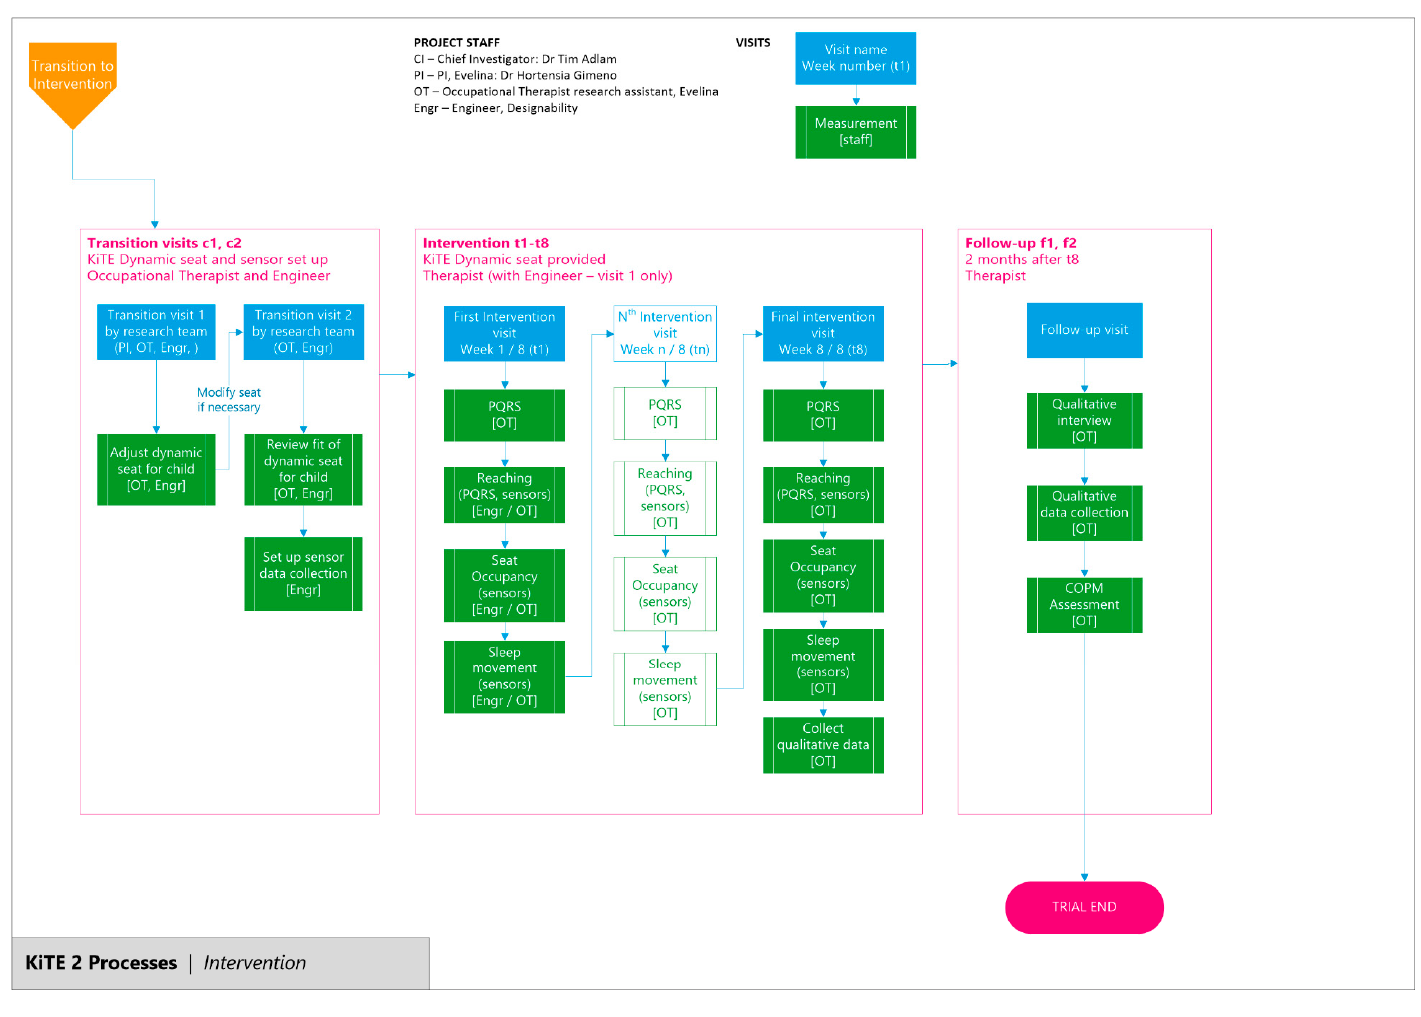
Figure 2. ( a ) Flow chart of baseline measurements and assessments. This chart should be read in conjunction with Table 1. ( b ) Flow chart of intervention period measurements and assessments. This chart follows Figure 2a and should be read in conjunction with Table